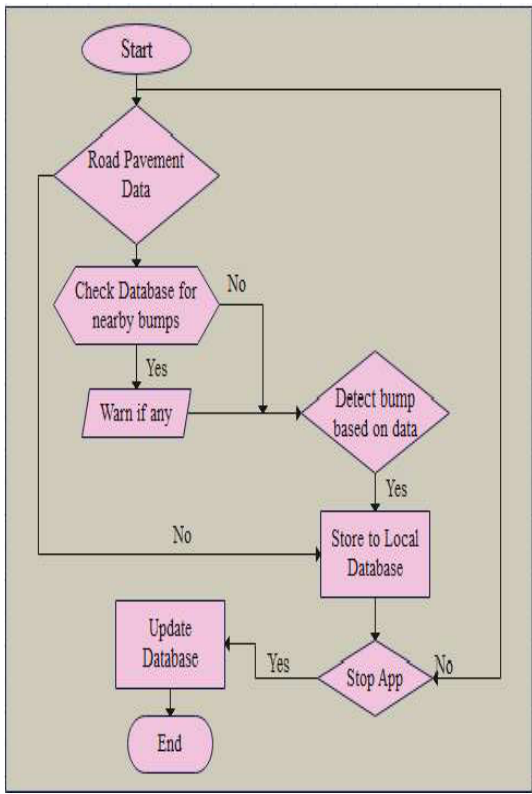
Figure 6 . Flowchart of low-cost road detection system.